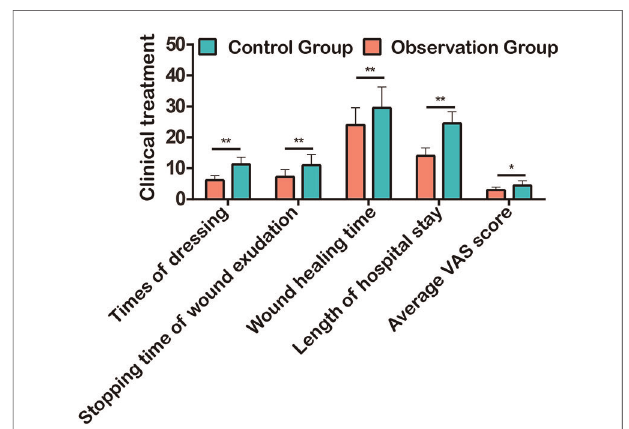
FIGURE 3 | Comparison of clinical treatment in terms of times of dressing, stopping time of wound exudation, wound healing time, hospital stay, and average VAS score. * P <0.05, ** P